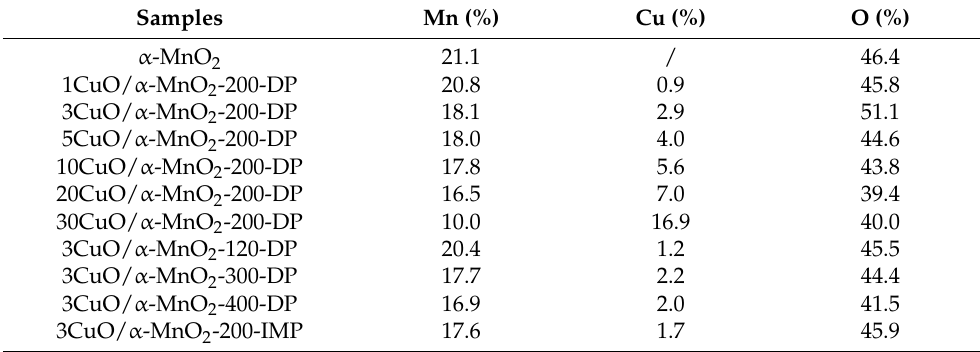
Table 1. The surface atomic concentration ratio of Mn, Cu, O of the catalysts based on XPS.